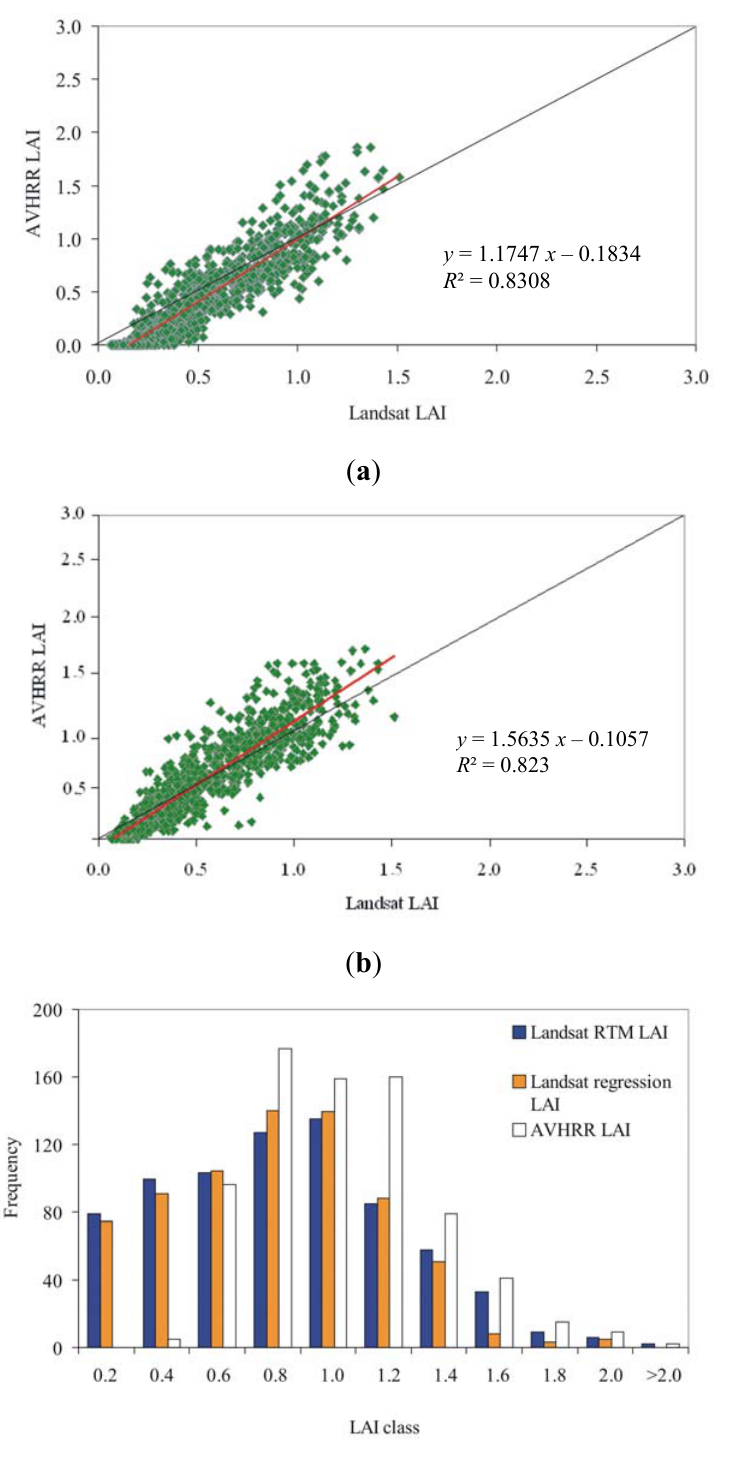
Figure 5. Validation of AVHRR LAI product in the grassland biome in the Shetsky test region. ( a ) Pixel-by-pixel ( n = 1,215) comparison of the aggregated fine-resolution LAI map retrieved using RTM algorithm and the AVHRR LAI for 2008. ( b ) Same as in panel (a), but retrievals from the regression-based Landsat ETM+ LAI for 2008. ( c ) Frequency distribution of LAI modeled from Landsat ETM+ data using the RTM and regression algorithm, and AVHRR